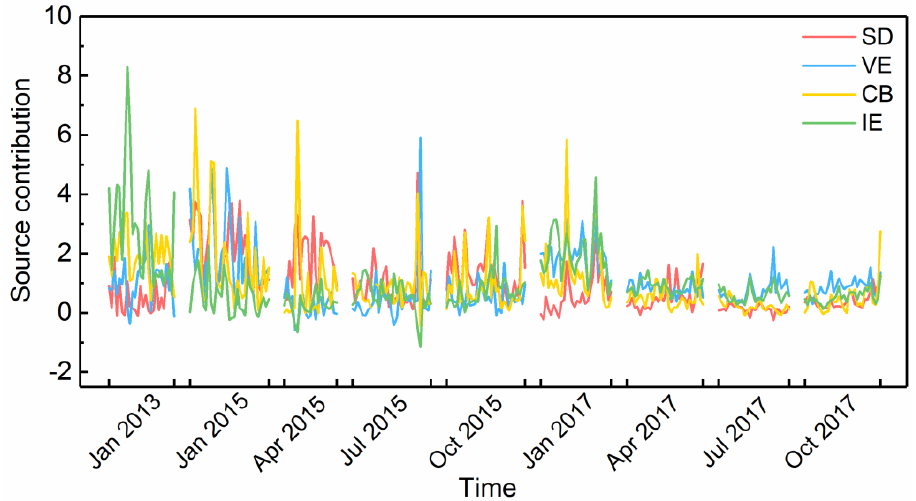
Figure 6. Time series plot of the source contributions. (n = 253).